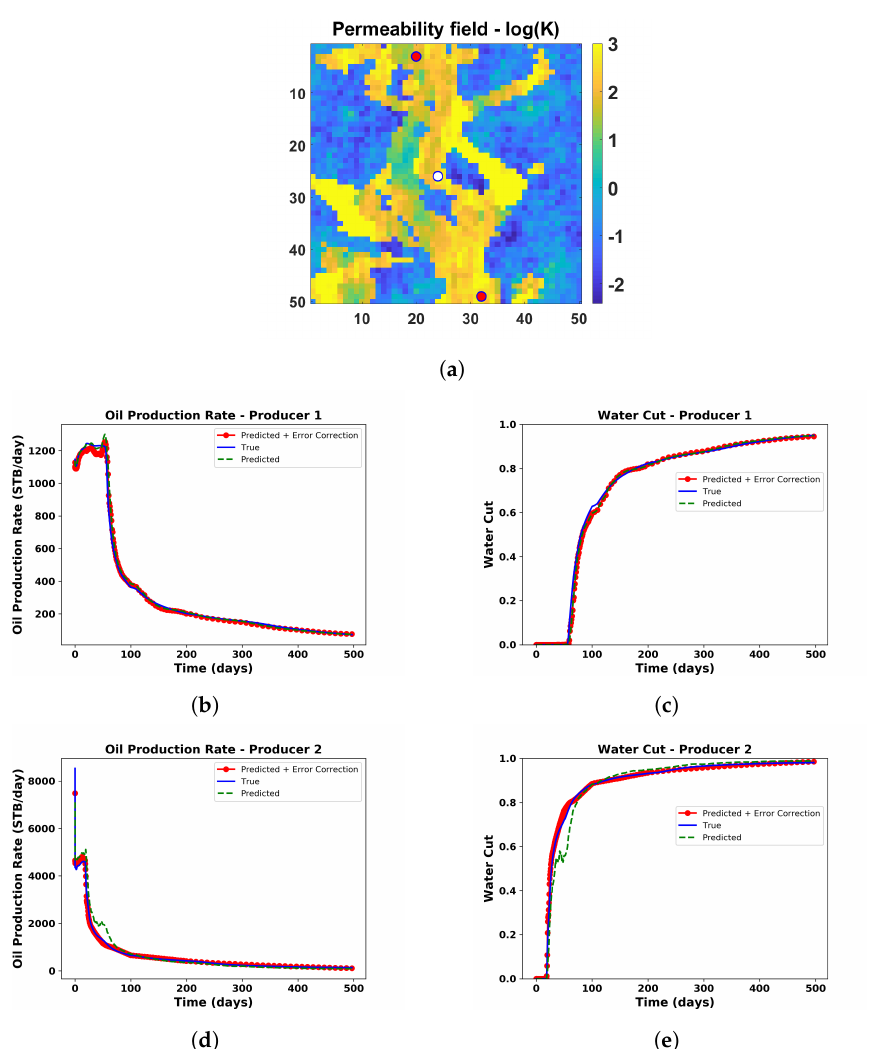
Figure 51. ( a ) Test case 2 with producer 1 at (20,3) and producer 2 at (32,49). ( b ) Comparison of oil production rate for producer 1, ( c ) comparison of water cut for producer 1, ( d ) comparison of oil production rate for producer 2, ( e ) comparison of water cut for producer 2, predicted using the global PMOR method alone (dotted green line) and after the implementation of the error correction model (red circled line) with the true solution (blue